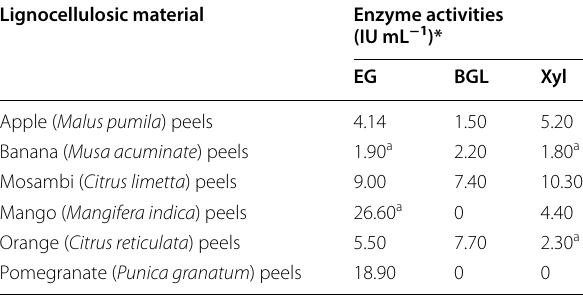
*The values represent mean of three replicates. The number with alphabet shows a significant standard deviation